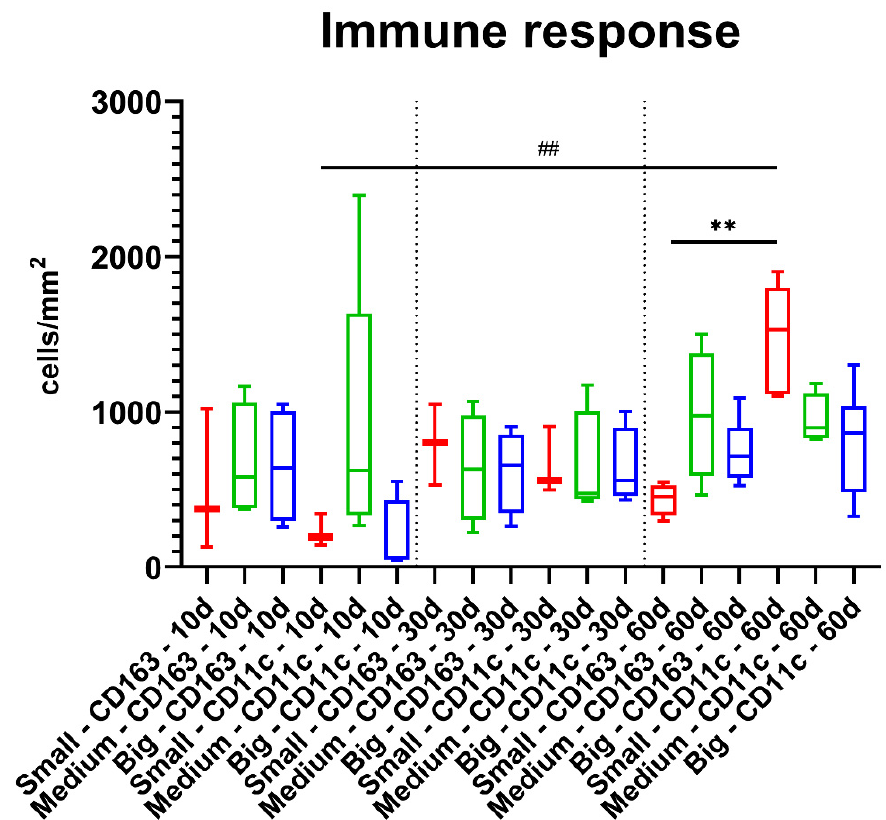
Figure 4. Histomorphometrical results of the measurements of macrophages subtypes (intraindividual: ** p < 0.01, interindividual: ## p < 0.01). Red: small granules, green: medium-sized granules, and blue: big granules. Table 2. Results of the histomorphometrical measurements of macrophages subtypes.